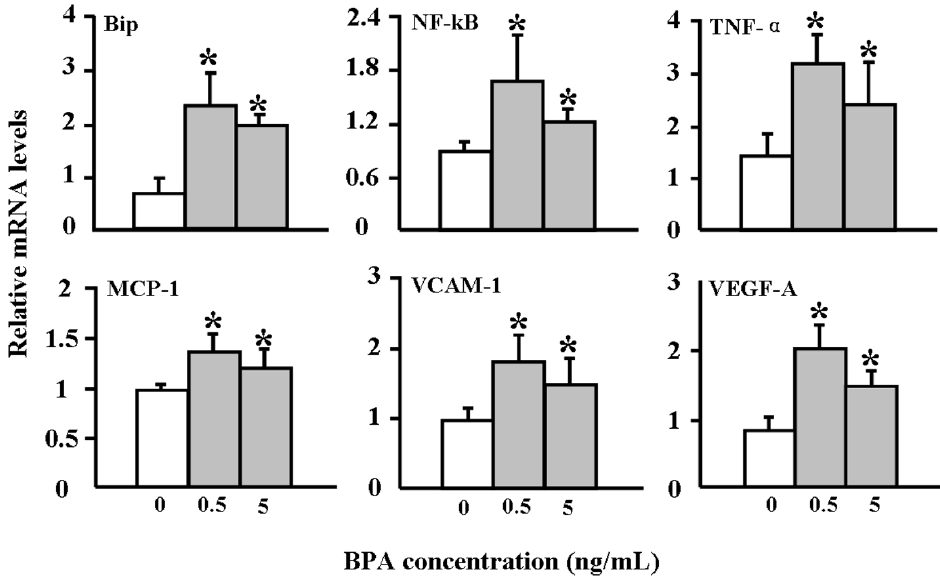
Figure 10. Effects of BPA incubation on ER stress and inflammatory responses in HUVEC cells. Cultured HUVECs were incubated with either vehicle or BPA (0.5 and 5 ng/mL) for 24 hr, after which total RNA was extracted for RT-PCR analysis. The analysis was performed three times, and each assay was performed in triplicate. Representative data are shown as the means 6 SD. * p , 0.05 vs. vehicles.